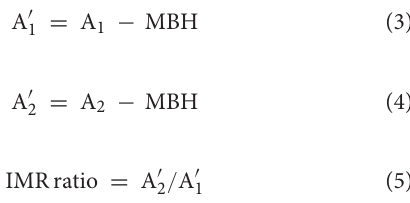
with the highest IMR, and a ratio of 0 indicates absence of